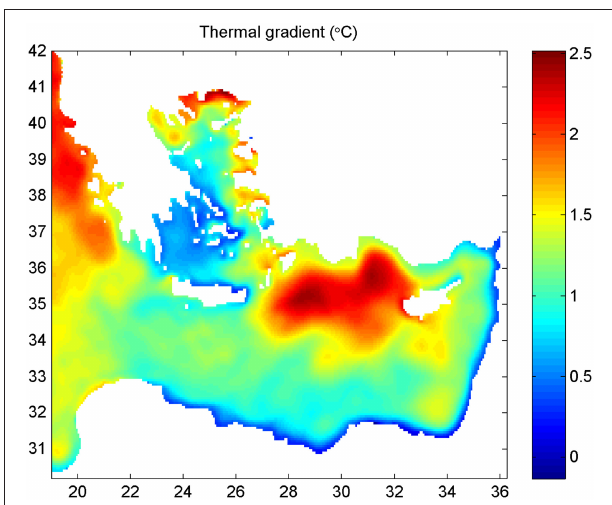
FIGURE 7 | Mean thermal gradient between 1.5m and 24.1m depth for the Eastern Mediterranean during 2006-2015.